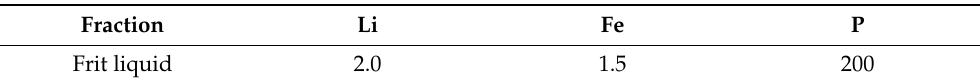
Figure 16. Products of the experiment LFP-C in Design 1: ( a ) flame formation in exhaust gas flow; ( b ) slag; ( c ) ceramic ring and mortar seen from the bottom; ( d ) metal. Table 7. Results of the individual fractions after the experiment LFP-C in Design 1. Table 6. Results from the frit liquid of the gas scrubber after suction of the exhaust gas in Design 1 for LFP-C in mg/L.